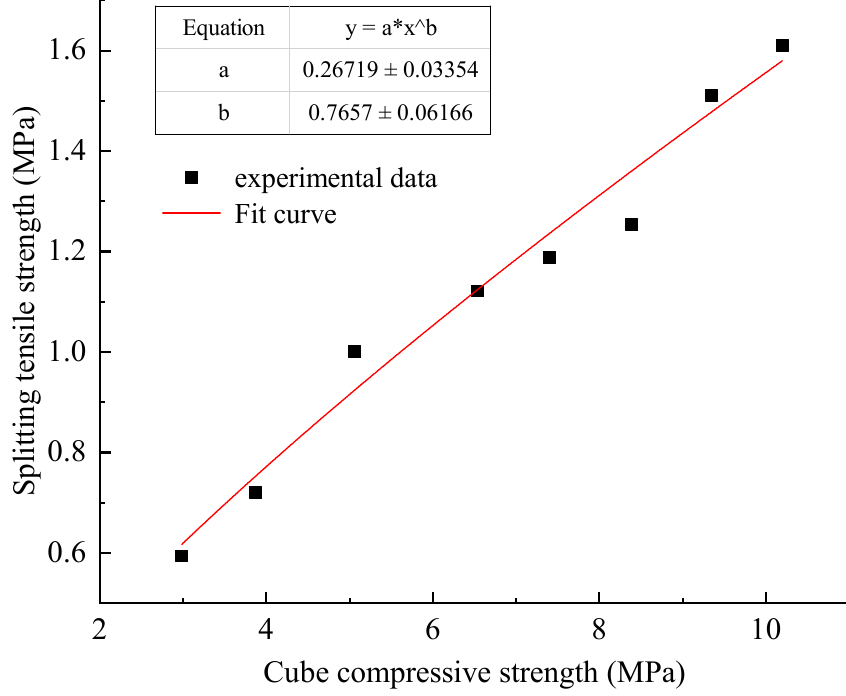
Figure 5. Relationship between cube compressive strength and splitting tensile strength. Fitting Formula (1) residual sum of squares is 0.030, the goodness of fit R 2 = 0.966, the fitting effect is better. It can be seen that the uniaxial compressive strength can be used to predict the splitting tensile strength accurately through Formula